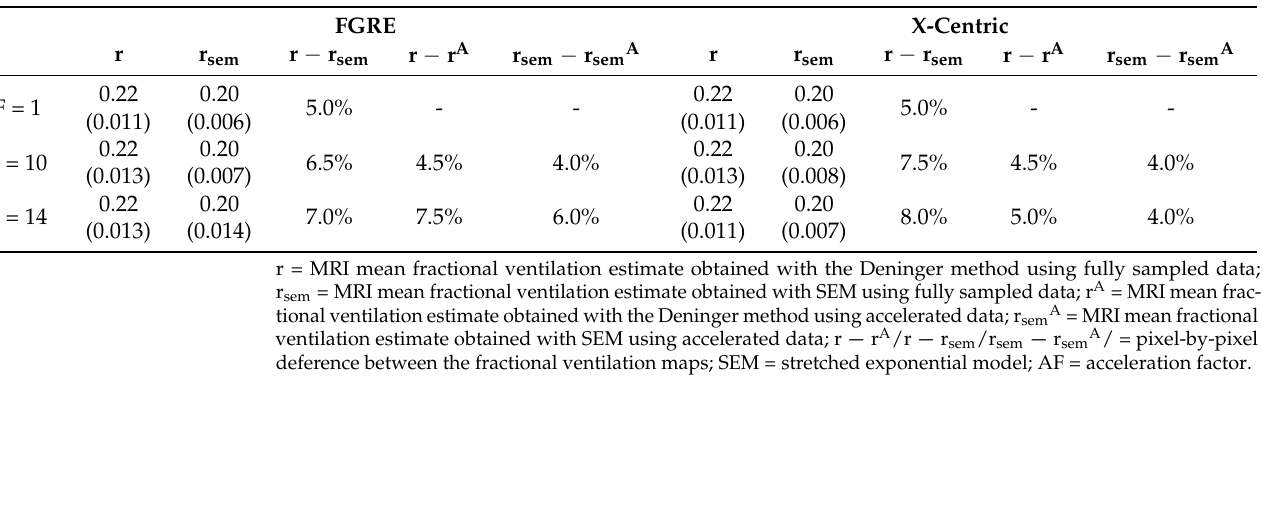
Figure 6. Representative 19 F MRI-based fractional ventilation maps generated by using the Deninger method ( D ) and the SEM ( S ) from normal animal using two different imaging approaches (FGRE and X-Centric). The top panel shows fractional ventilation maps calculated for the original fully sampled k-space. The middle and bottom panels show the maps generated for the retrospectively under-sampled data mimicking AF = 10 and 14, correspondingly. Table 1. 3 He MRI-based Fractional-Ventilation Measurements (average from all